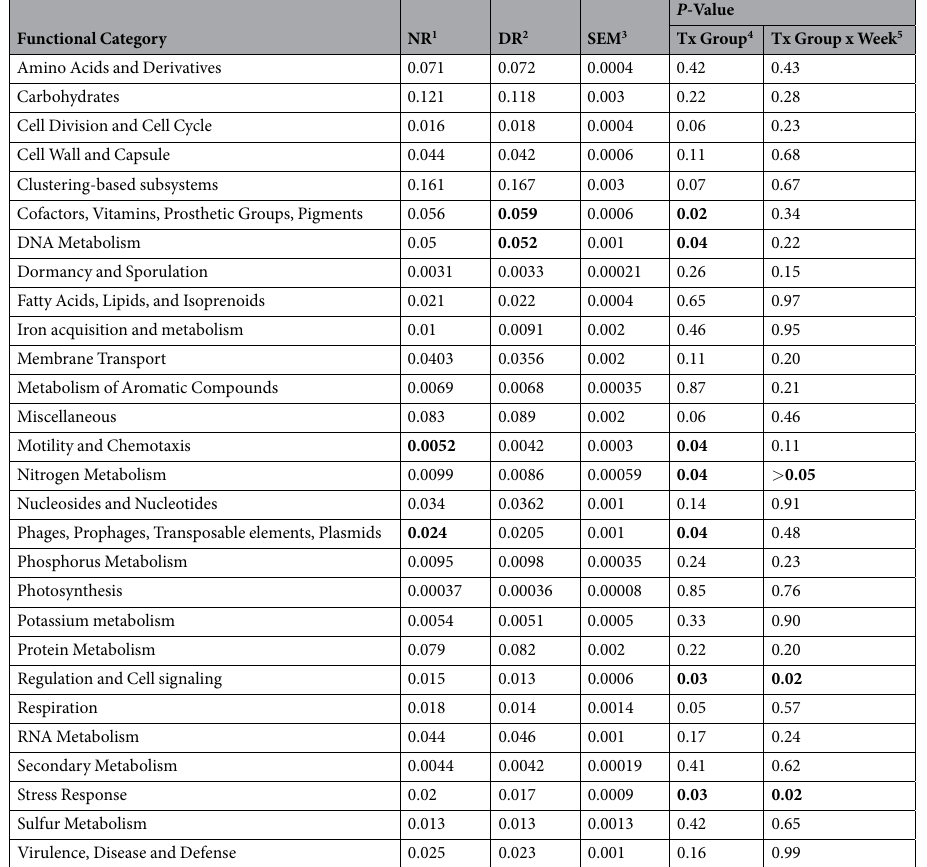
Table 1. Distribution of microbial cell function in calf feces by control (NR) and treatment group (DR). Least square means is accumulated by treatment group for samples collected at week 1, 3 and 6. P -value is relative to significant differences in cell functions between treatment groups and for different sampling times. 1 Calves fed raw milk without the addition of sub-MICs of antimicrobial drugs; 2 Calves fed raw milk with the addition of sub-MICs of ceftiofur, penicillin, ampicillin, and oxytetracycline from birth to 6 weeks of age; 3 Standard error of the mean; 4 P -value comparing function relative abundance between treatments groups (NR vs DR) for the mixed linear regressions; 5 P -value comparing function relative abundance interaction between treatment groups (NR vs DR) and week samples was collected (1, 3 and 6) for the mixed linear